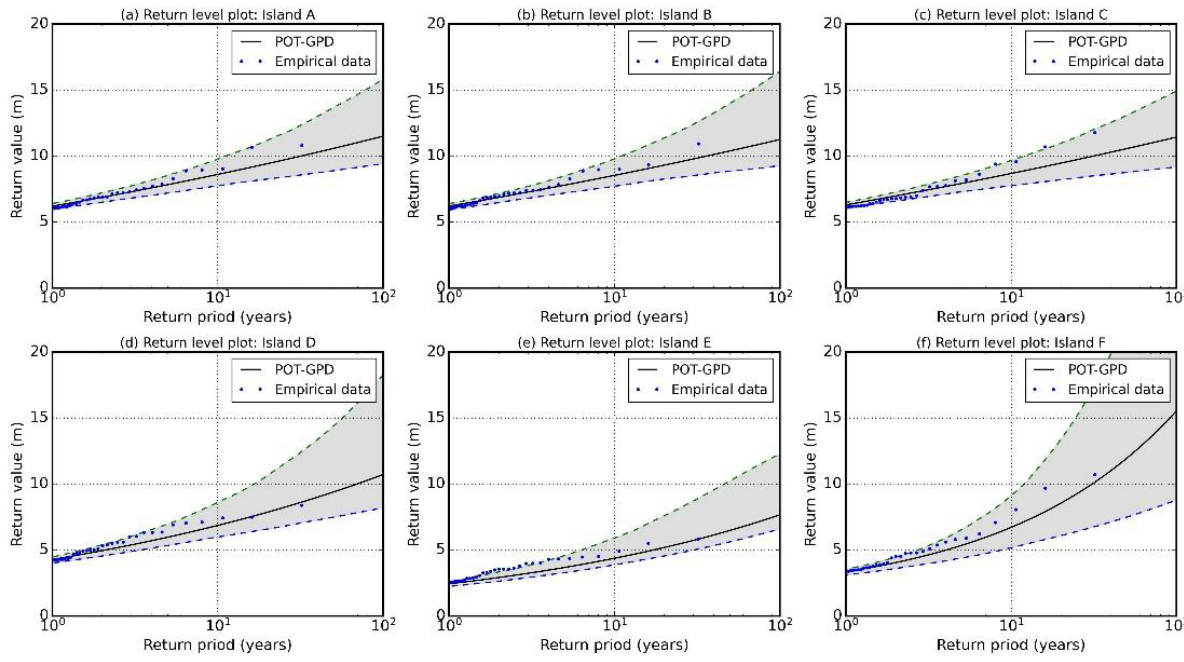
Figure 27. Regression curve of Hs at sites using POT-GPD method. Table 4. Hundred-year return level estimation results at six sites.